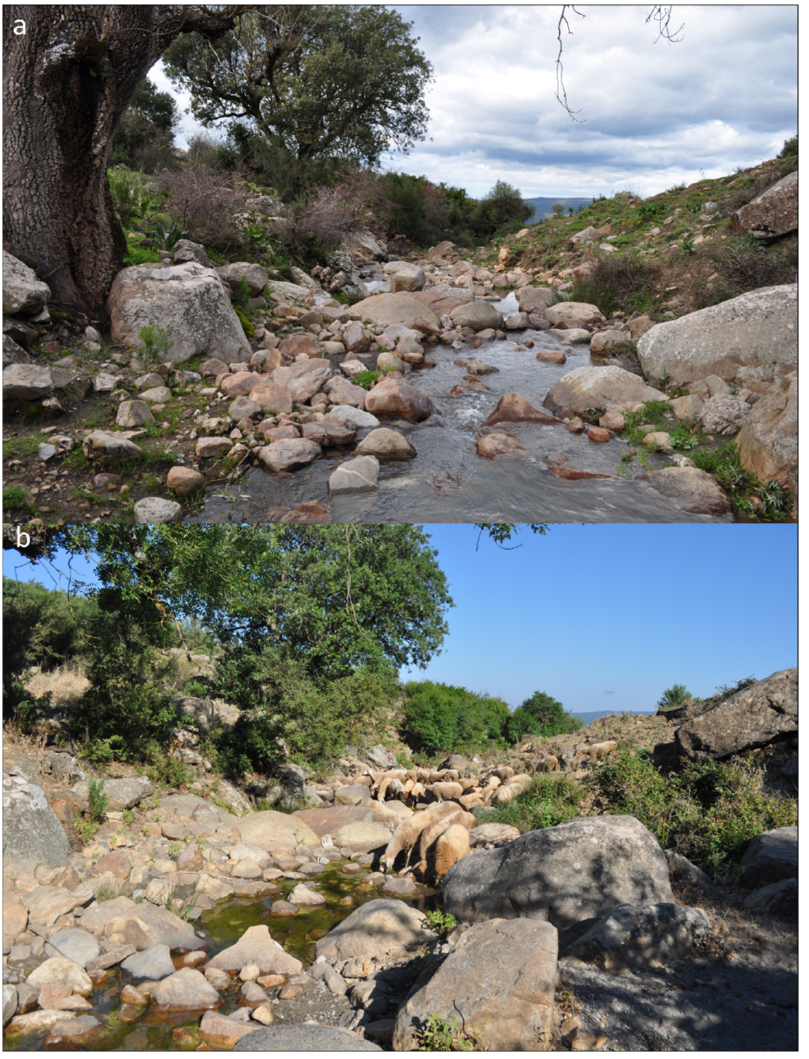
Figure 2. View of Guitna sup., a typical habitat of Rhithrogena sartorii during winter ( a ) and summer ( b ).